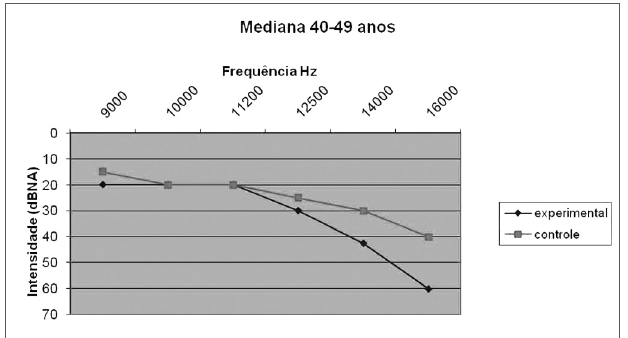
Gráfico 2. Comparação entre a mediana dos limiares de audibilidade do grupo experimental e controle na faixa etária de 40-49